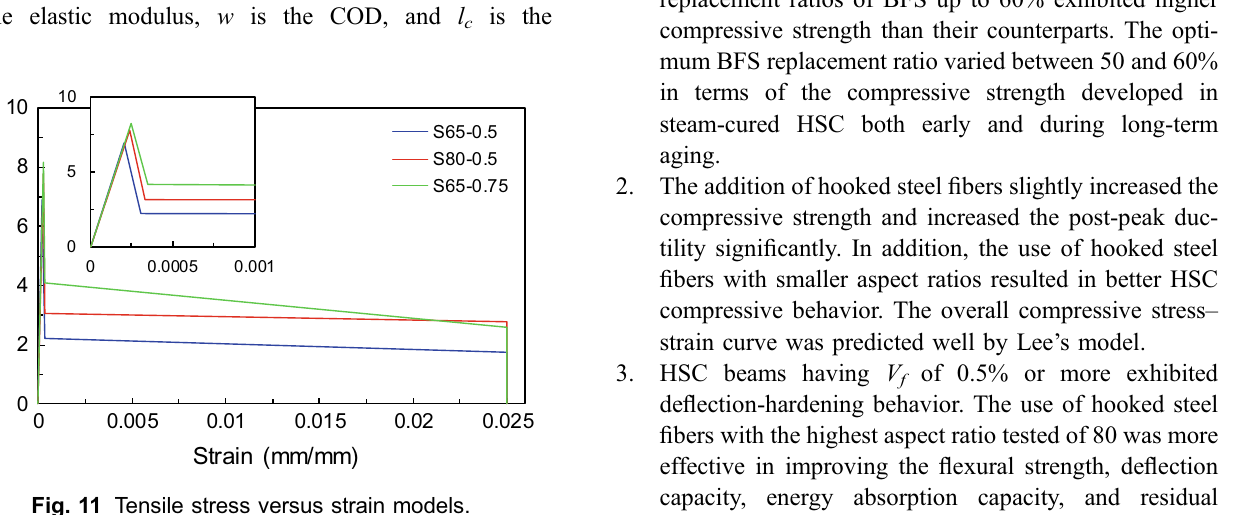
Fig. 11 Tensile stress versus strain models.